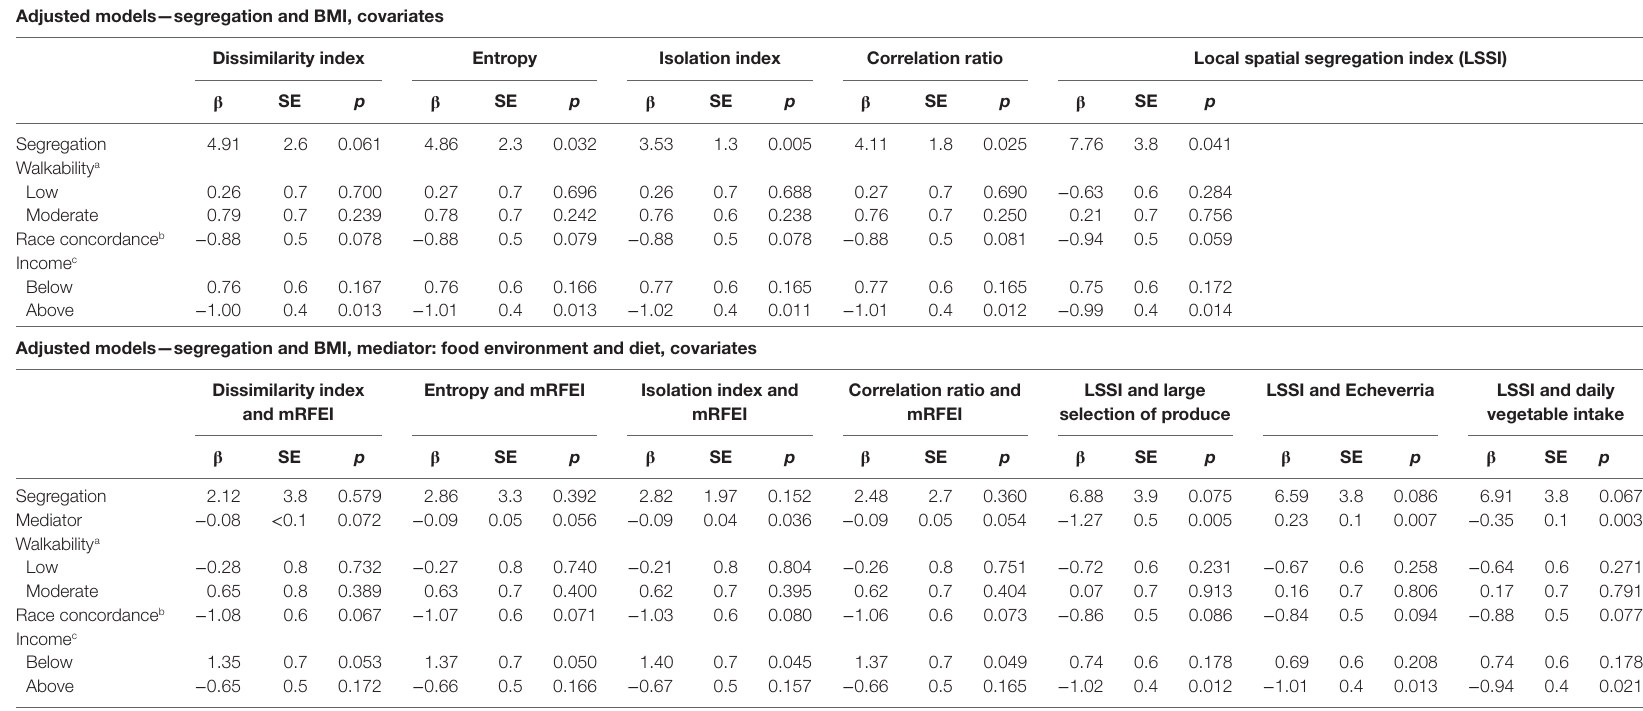
TaBle 3 | Race, income, and walkability adjusted regression estimates of association of residential racial segregation and body mass index (BMI), with and without mediation by food environment. adjusted models—segregation and BMi, covariates Dissimilarity index entropy isolation index correlation ratio local spatial segregation index (lssi)